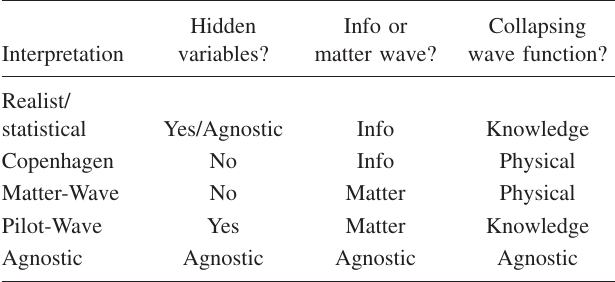
TABLE II. A summary of our characterizations of four formal interpretations of quantum mechanics, in terms of three interpretive themes. The Agnostic perspective is not considered to be a formal interpretation in itself, but is included for